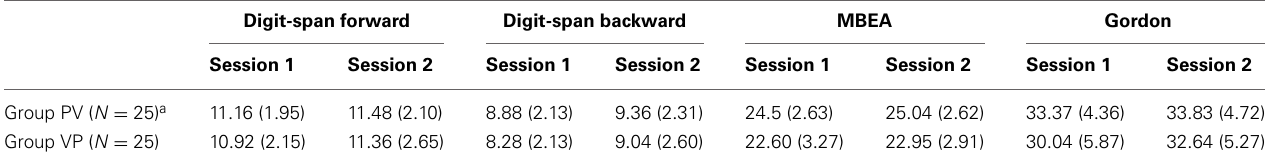
Table 2 | Means (and SD ) of scores on the memory